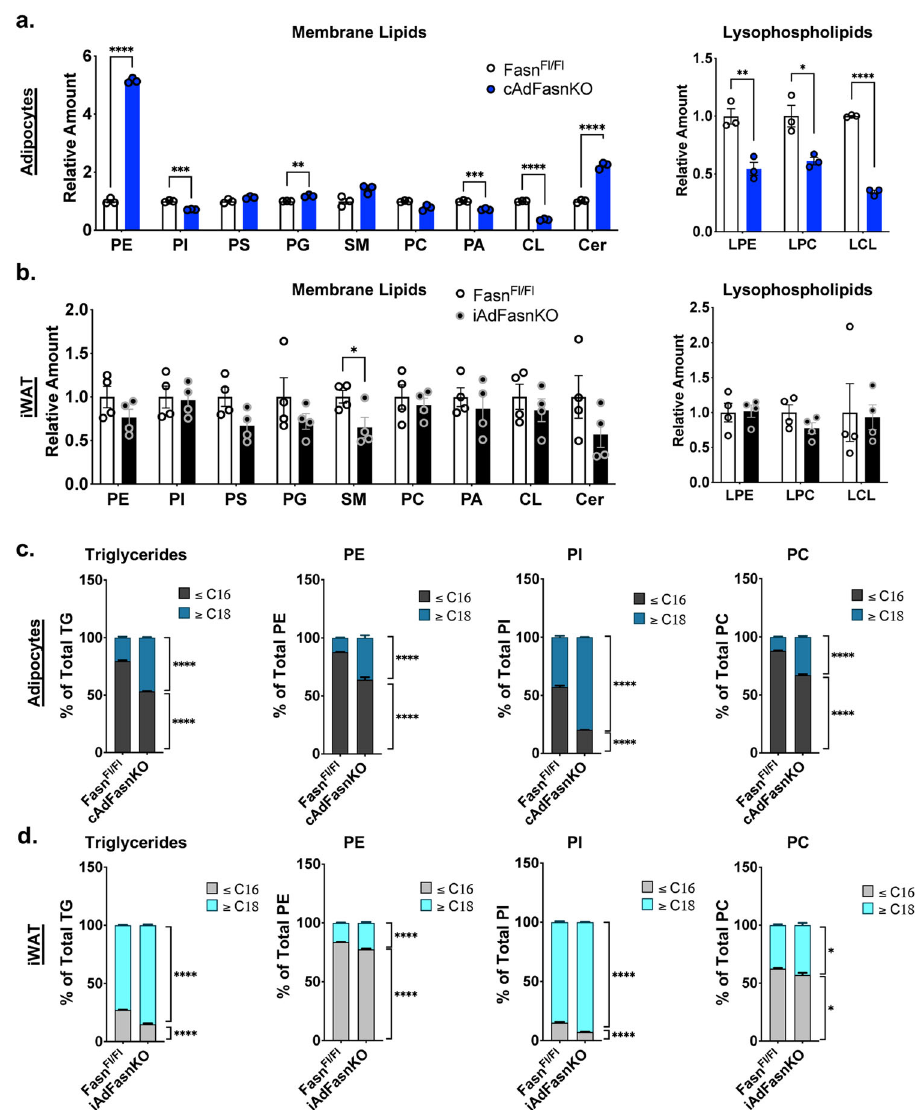
Fig. 5 | Deletion of Fasn alters the cellular lipidome in vitro and in vivo. Lipi- domics analyses from in vitro differentiated Fasn Fl/Fl and cAdFasnKO primary adi- pocytes and subcutaneous WAT from Fasn Fl/Fl and iAdFasnKO mice. a Relative amounts of different lipid classes from in vitro differentiated adipocytes and ( b ) in vivo iWAT. Two-tailed t tests: P Values=( a ) from left to right <0.00001, 0.000738, 0.061515, 0.004430, 0.061515. 0.054831, 0.001855, 0.000028, 0.00042, 0.013057, 0.016585,<0.00001, ( b ) from left to right 0.178372,0.820148, 0.057631, 0.284882, 0.041275, 0.580865, 0.50506, 0.457181, 0.184524, 0.90473, 0.141867, 0.885965, *<0.05, **<0.01, ***<0.001, ****<0.0001. Fatty acyl chain com- position of different lipid classes in vitro ( c ) and in vivo ( d ). Percent of indicated